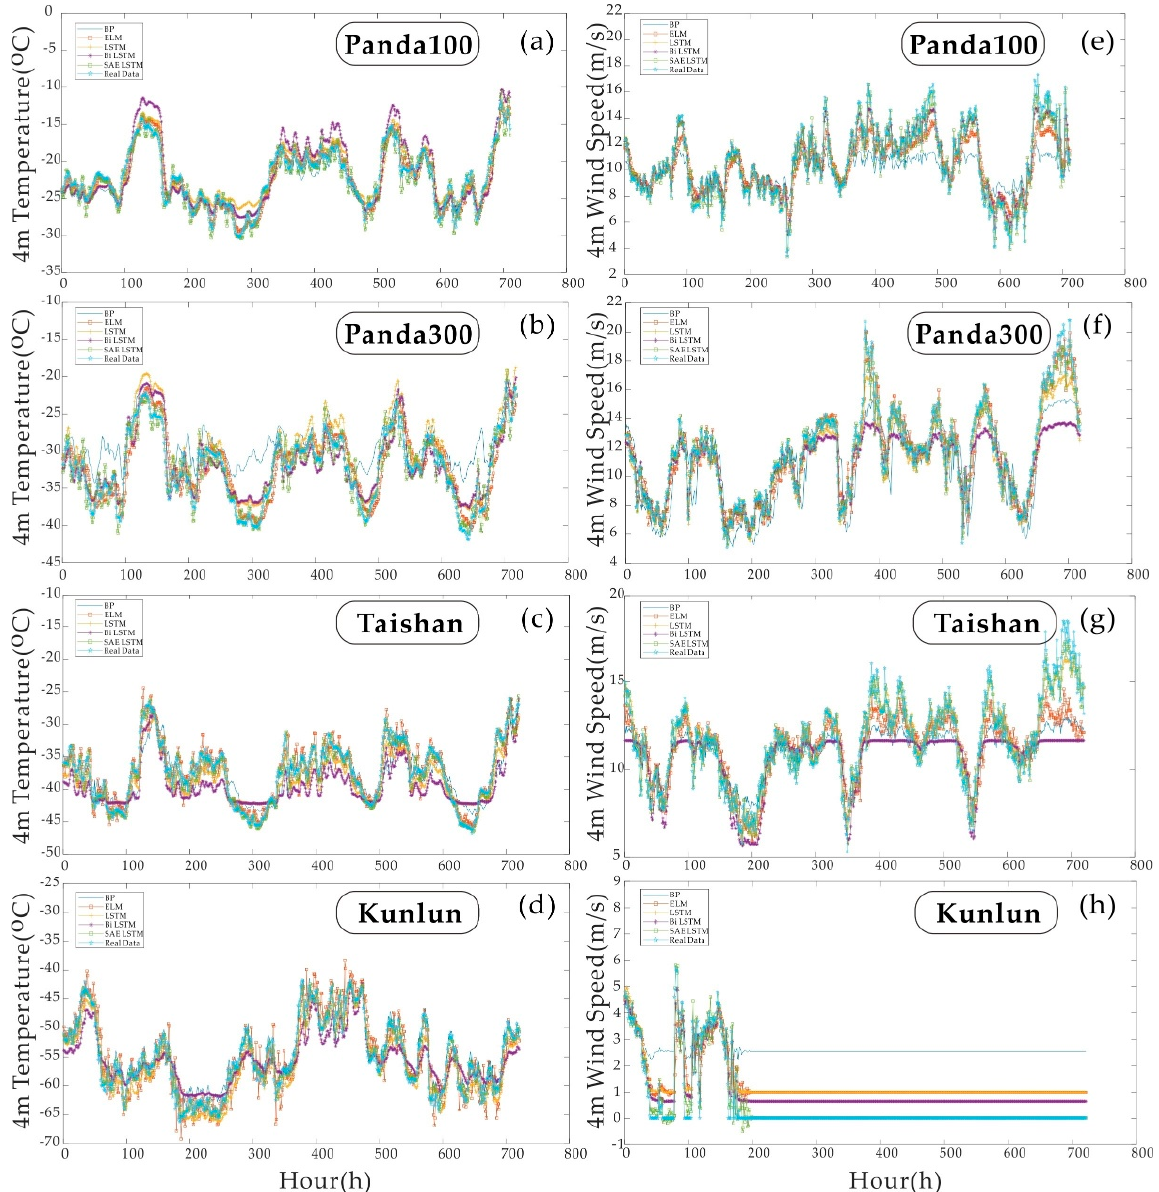
Figure 10. Results of the single-step predictions: ( a – d ) are the results of the 4 m temperature single-step predictions for the four sites. ( e – h ) are the results of a single-step prediction of the 4 m wind speed at the four areas.